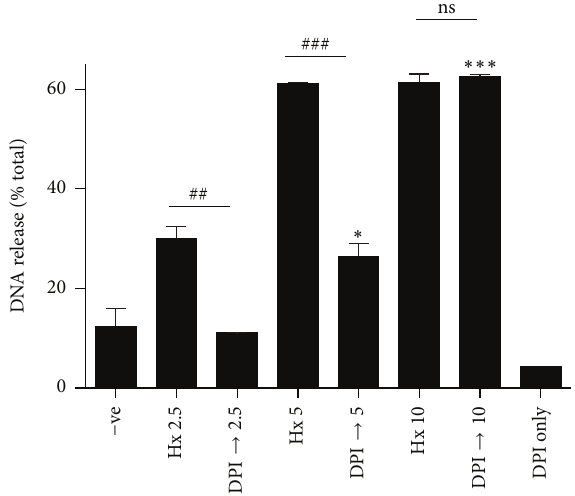
Figure 5: Hepoxilin A3-mediated NETosis is both NOX-dependent and NOX-independent depending on the dose of HxA3. A fluores- cence plate reader assay was utilized to monitor NET DNA release upon stimulation with HxA3 in the presence or absence of the NOX inhibitor DPI (20 𝜇 M) ( 𝑛 = 2 ; ∗ 𝑃 < 0.05 ; ∗∗∗ 𝑃 < 0.001 compared to cells activated with HxA3 (2.5 𝜇 g/mL) in the presence of DPI ( DPI → 2.5) ; ## 𝑃 < 0.01 ; ### 𝑃 < 0.001 (one-way